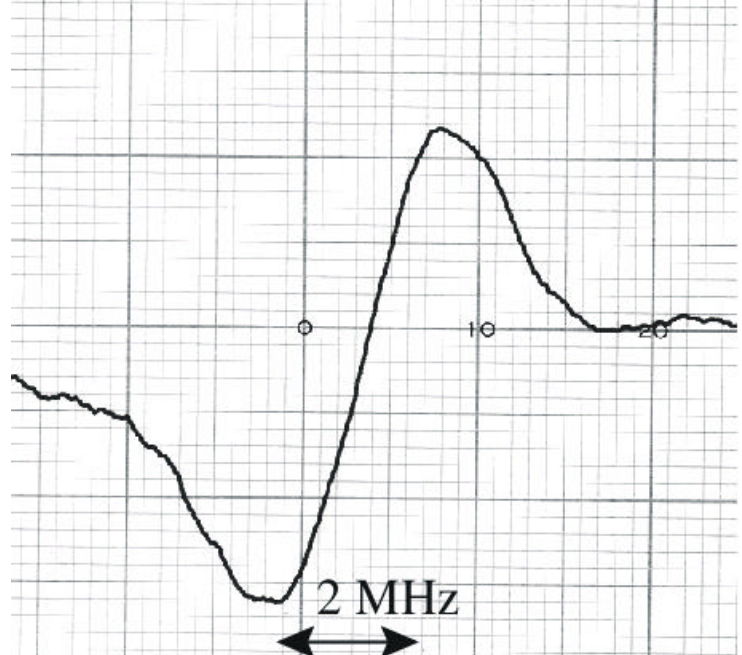
Figure 3. Recorder tracing of the microwave transition E, 1 0 ‹ 2 - 1 in the ground state at 60531.47 MHz with the infrared transition 1 - pressure is 167 mTorr. The maximum and the minimum of the signal are separated by 2 MHz in frequency, coming from the microwave frequency